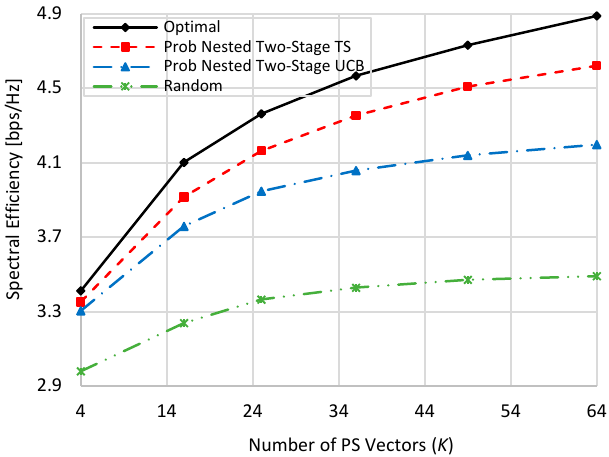
Figure 2. Spectral efficiency against the used number of beams when M = N = K at zero blockage.